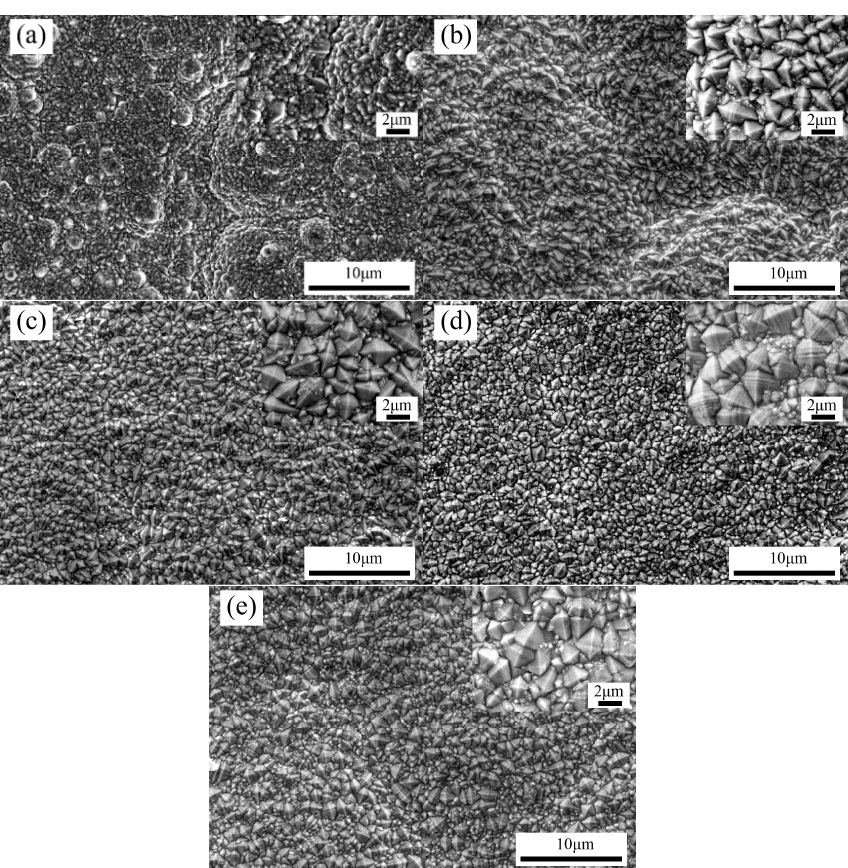
Figure 2. Surface morphologies of the Ni–Co–BN (h) nanocomposite coatings with pulse frequency of 4 kHz and varying duty cycles: ( a ) 0.1, ( b ) 0.3, ( c ) 0.5, ( d ) 0.7, ( e ) 0.9.